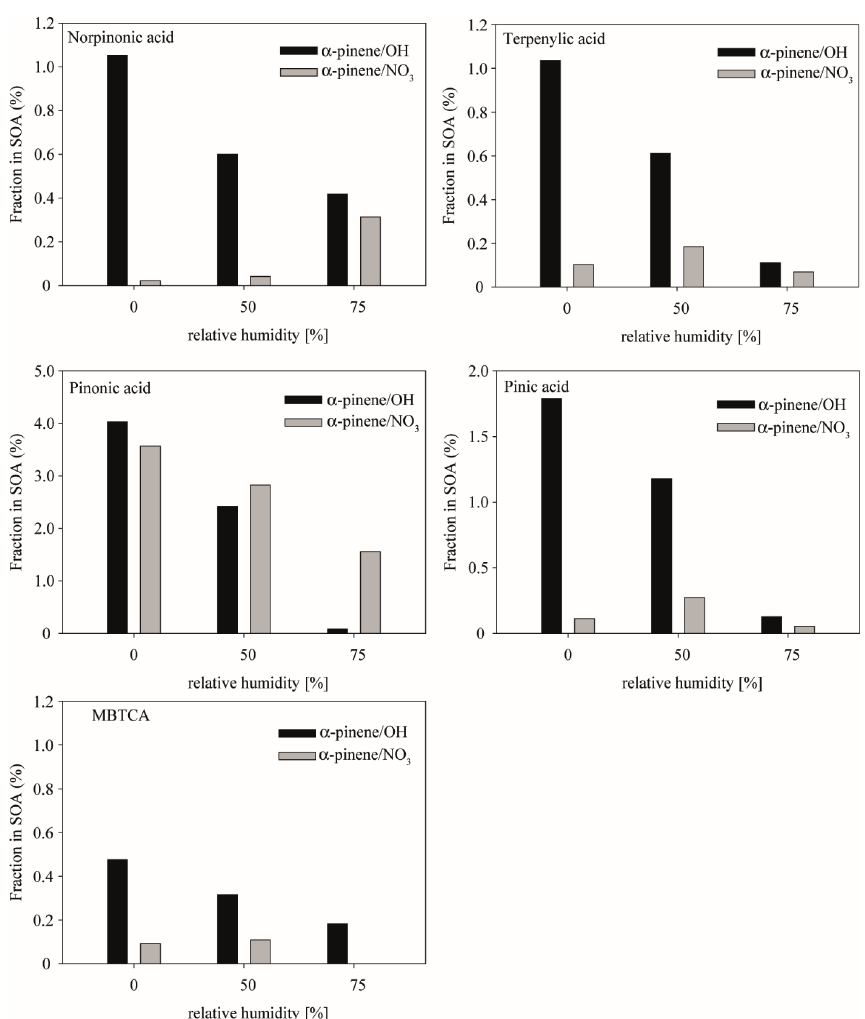
Figure 6. Fraction of α -pinene marker compounds norpinonic acid, terpenylic acid, pinonic acid, pinic acid, and MBTCA for OH-radical reaction (black) and NO 3 -radical reaction